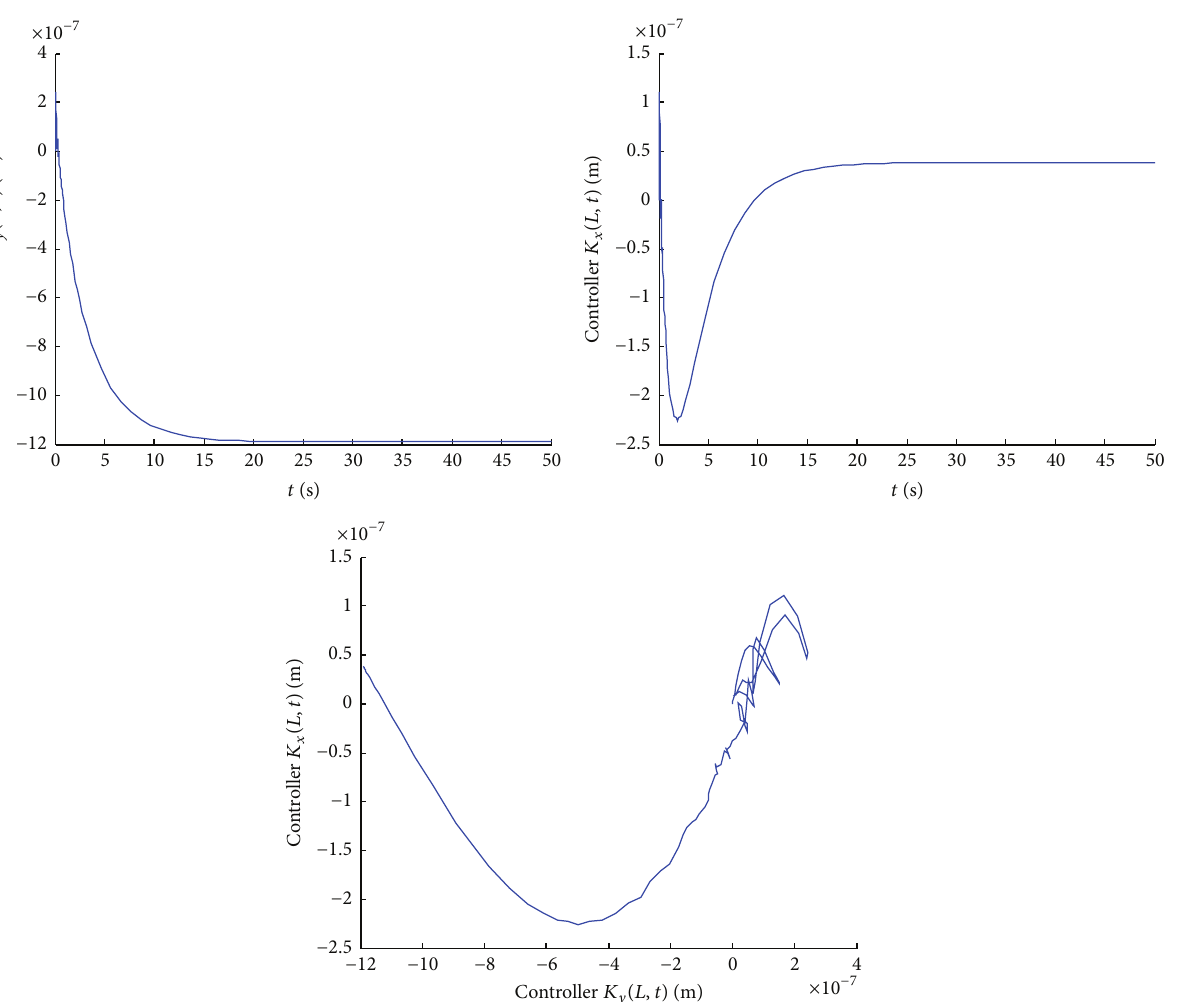
Figure 10: Amplitudes and phase plane of controller 𝐾 for flap/lag motions under 𝑈 = 65 m/s with zero initial condition.